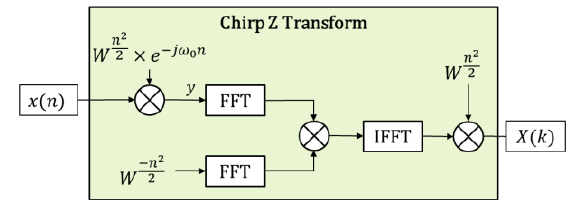
Fig. 5. Fast CZT Algorithm: Block